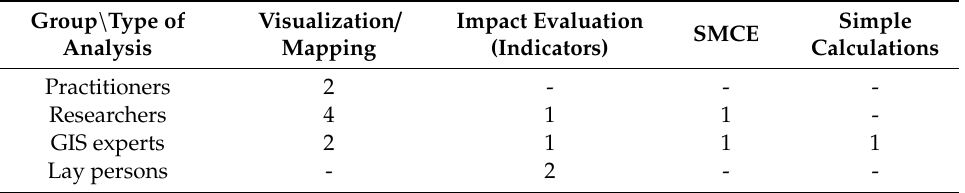
Table 1. Principal spatial